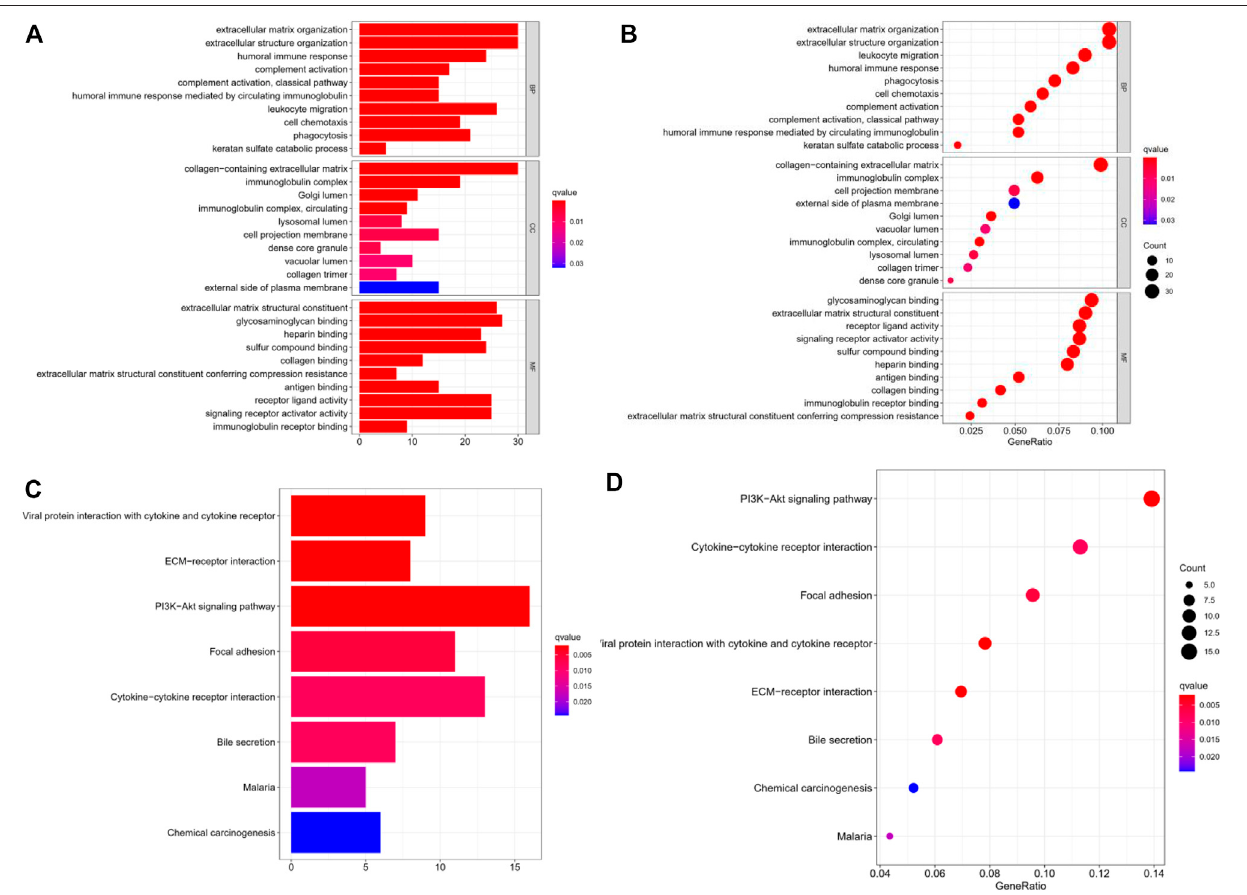
FIGURE 2 | Gene ontology and KEGG analysis of the gene expression of the two TMB groups. (A,B) GO enriched analysis of differential genes in BP, CC, MP. (C,D) KEGG analysis with these differential genes were enriched in PI3K-AKt, cytokine-cytokine receptor interaction and focal adhesion axis. TMB: tumor mutation burden; BP: biological process; CC, cellular component; MP, molecular function; KEGG, kyoto encyclopedia of genes and genomes.